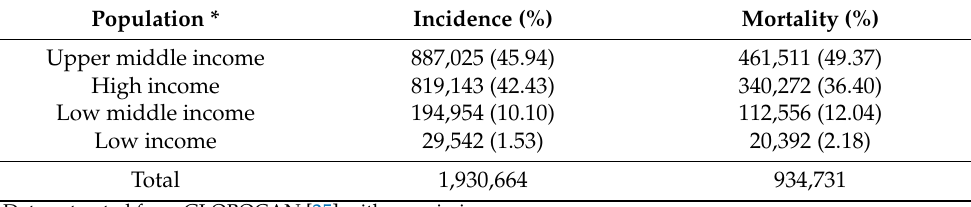
Table 1. World CRC estimated age-standardized incidence and mortality rates in 2020 (all ages). Population